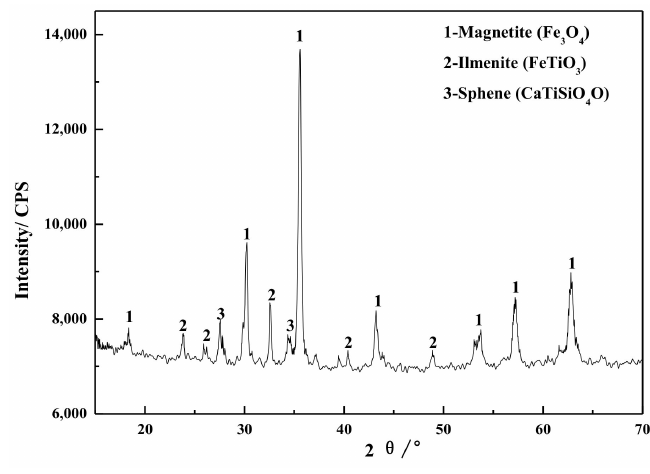
Figure 1. XRD pattern of the